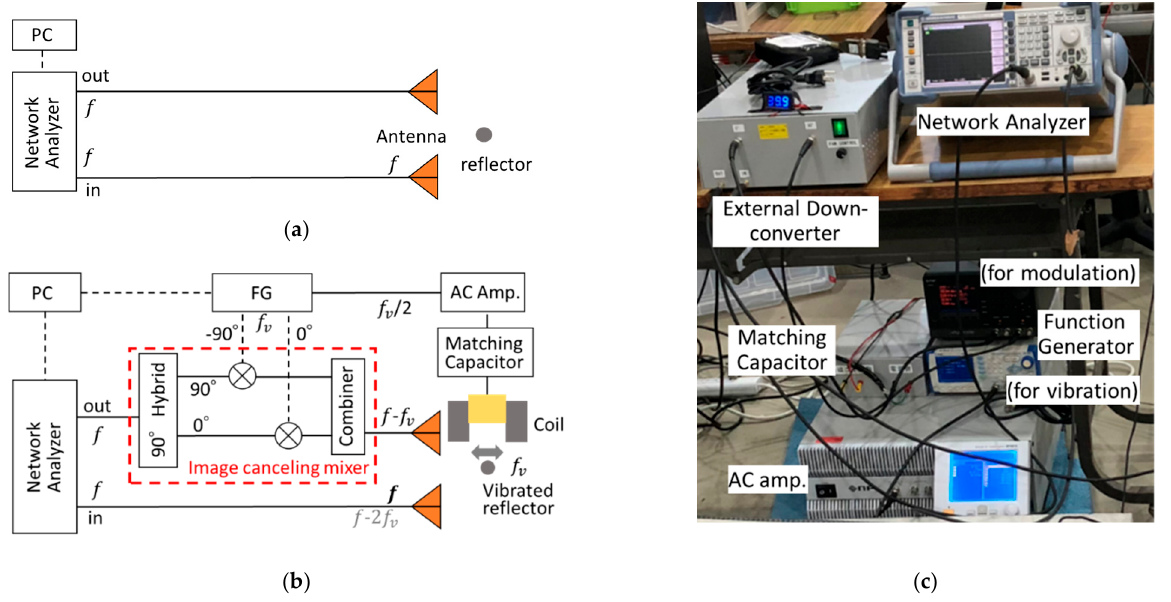
Figure 3. Block diagram of vibro-Doppler radar system based on network analyzer: ( a ) for non-modulation component; ( b ) for Doppler modulation component; ( c ) Photo of developed vibro-Doppler radar measurement system.